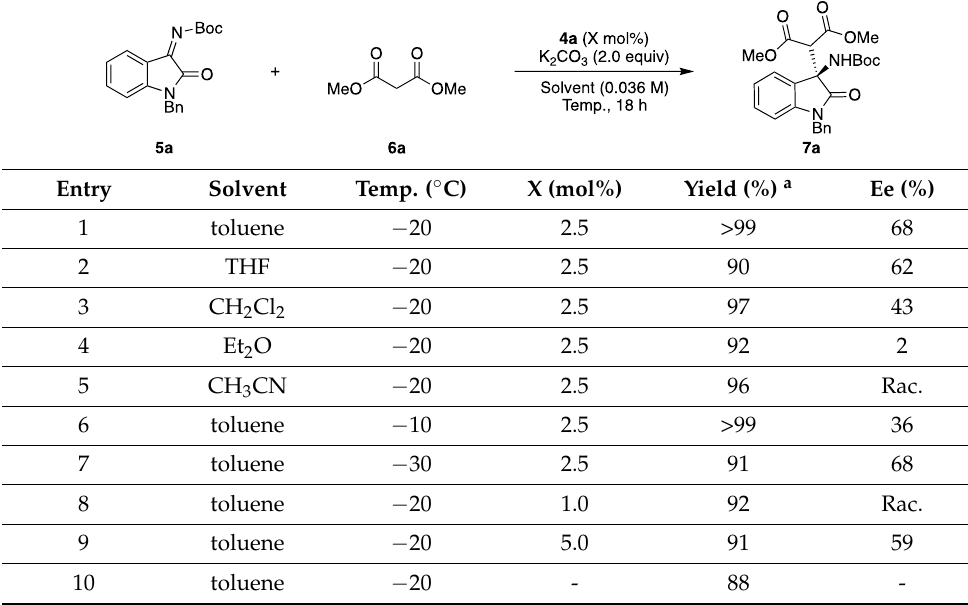
Table 1. Reaction condition optimizations.